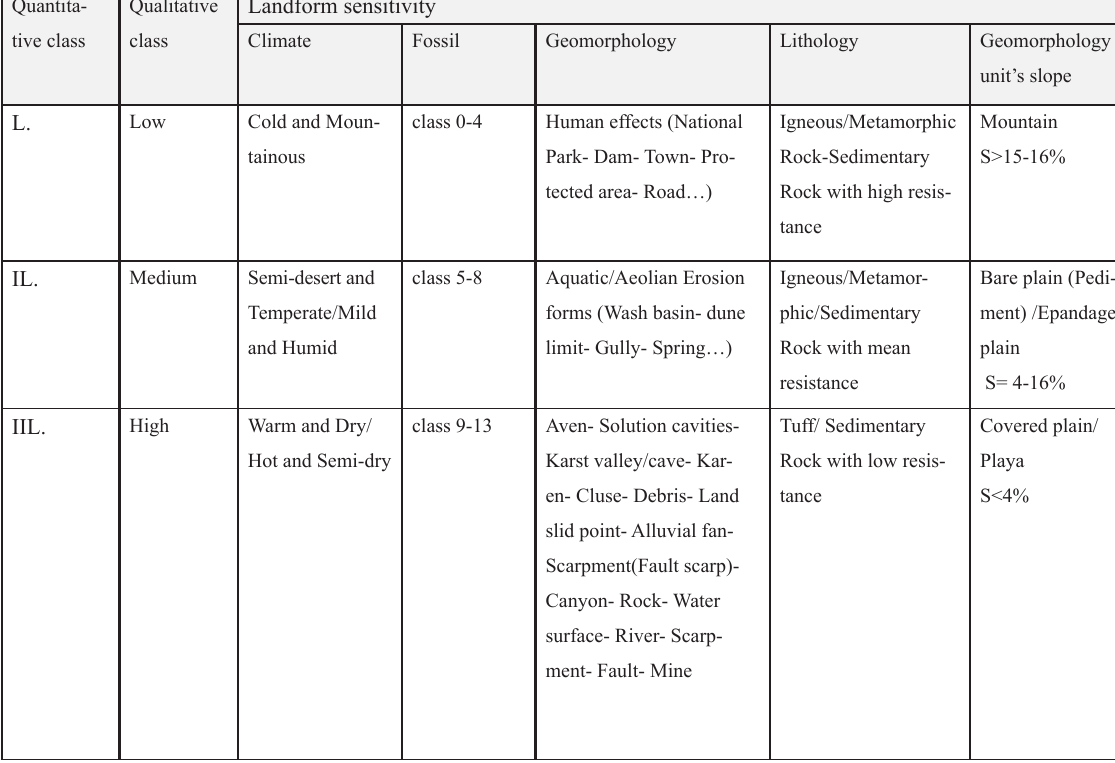
Table 1. How to score and classify the sub-criteria used in the sensitivity map